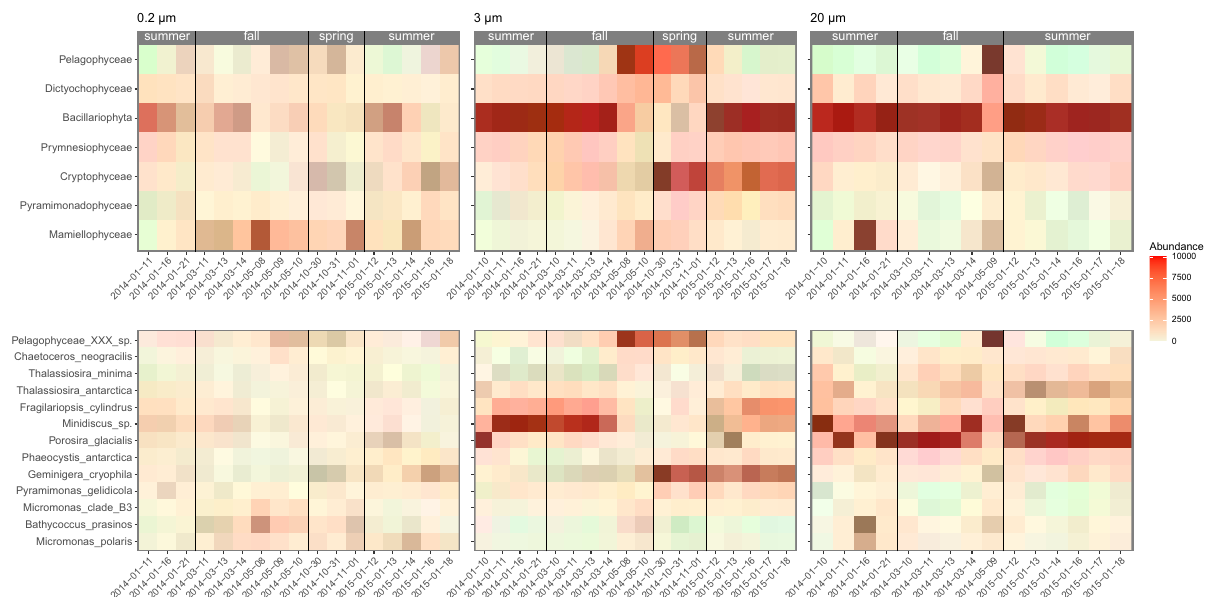
Figure 4. Change in the main phytoplankton groups (excluding dinoflagellates) at class (top) and species (bottom) levels in Fildes Bay during the study period based on the 18S rRNA gene in filtered surface samples. The color scale of the heatmap correspond to the normalized abundance of each taxon. Left: 0.2–3 µ m . Middle: 3–20 µ m . Right: > 20 µ m . Season delimitation corresponds to meteorological